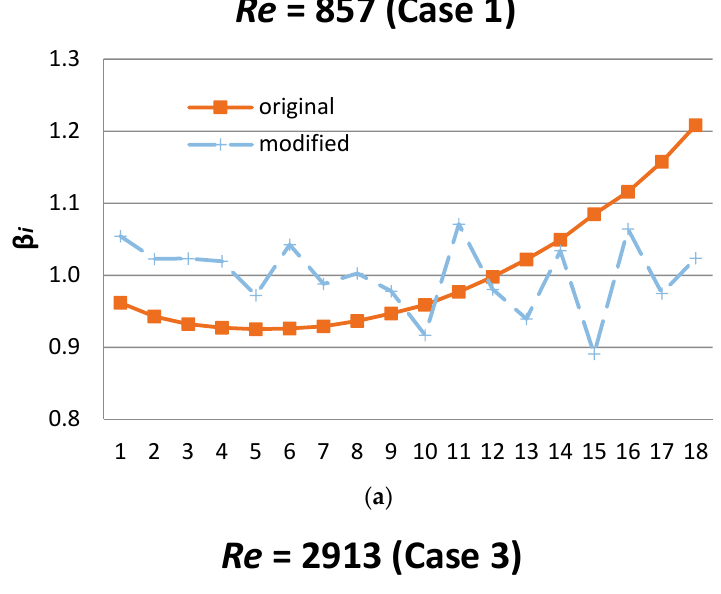
Table 5. Initial and final values of pressure drop, S β and Δ β in riser tubes before and after modification of riser diameters for flow uniformity enhancement.